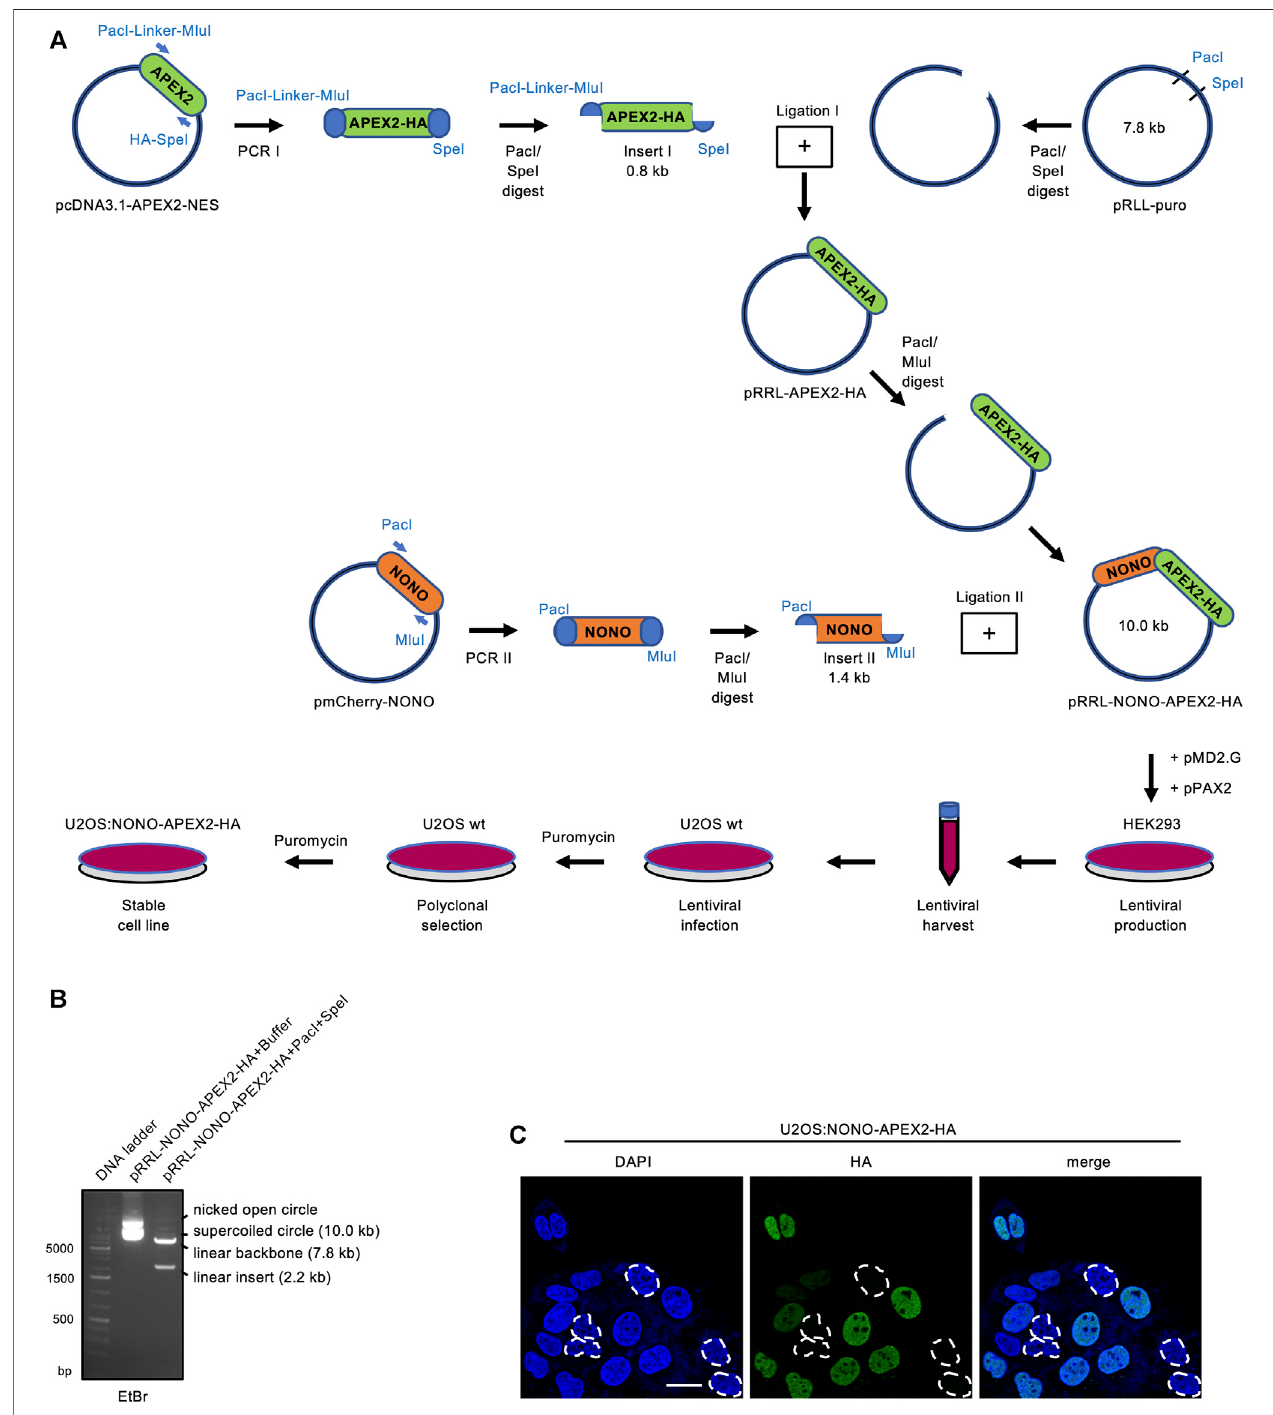
FIGURE 1 | Vector construction and expression of NONO-APEX2-HA. (A) Generation of the pRRL-NONO-APEX2-HA vector for lentiviral transduction, polyclonal selection and stable expression in U2OS cells. (B) Agarose gel electrophoresis of non-restricted pRRL-NONO-APEX2-HA vector (buffer) or upon incubation with PacI/ SpeI.DNAwasstainedwithethidiumbromide(EtBr). (C) ConfocalimagingofNONO-APEX2-HA.BrokenwhitecirclesindicatenucleiwithoutsubstantialNONO-APEX2- HA expression. Representative cells are shown. DAPI, 4 ‘ ,6-diamidino-2-phenylindol; scale bar, 10 µm.